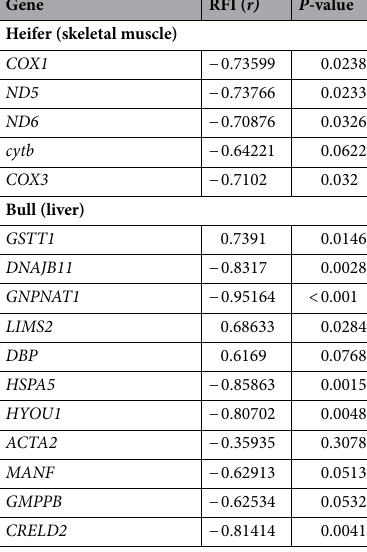
Table 4. Correlation between DEGs and RFI value in both heifers and bulls.